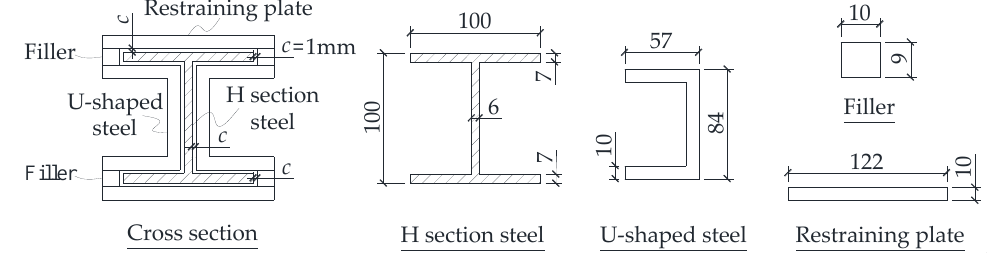
Figure 5. Configuration of the prototype specimen for the numerical model adapted from Ref. [23]. ( a ) Assembly of the prototype specimen. ( b ) Layout of the high strength bolts.